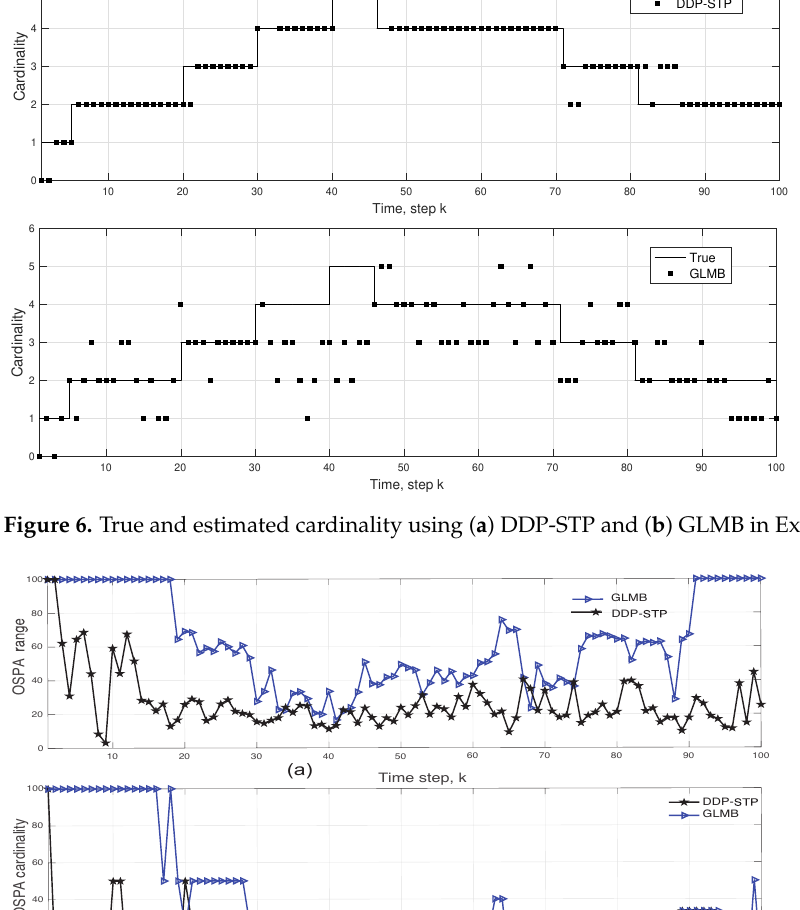
Experiment 2. DDP-STP for tracking multiple objects in close proximity. We consider a more enter the scene at times steps k = 0 , k = 5 , k = 20 , k = 30 , and k = 40 , respectively; they leave the scene